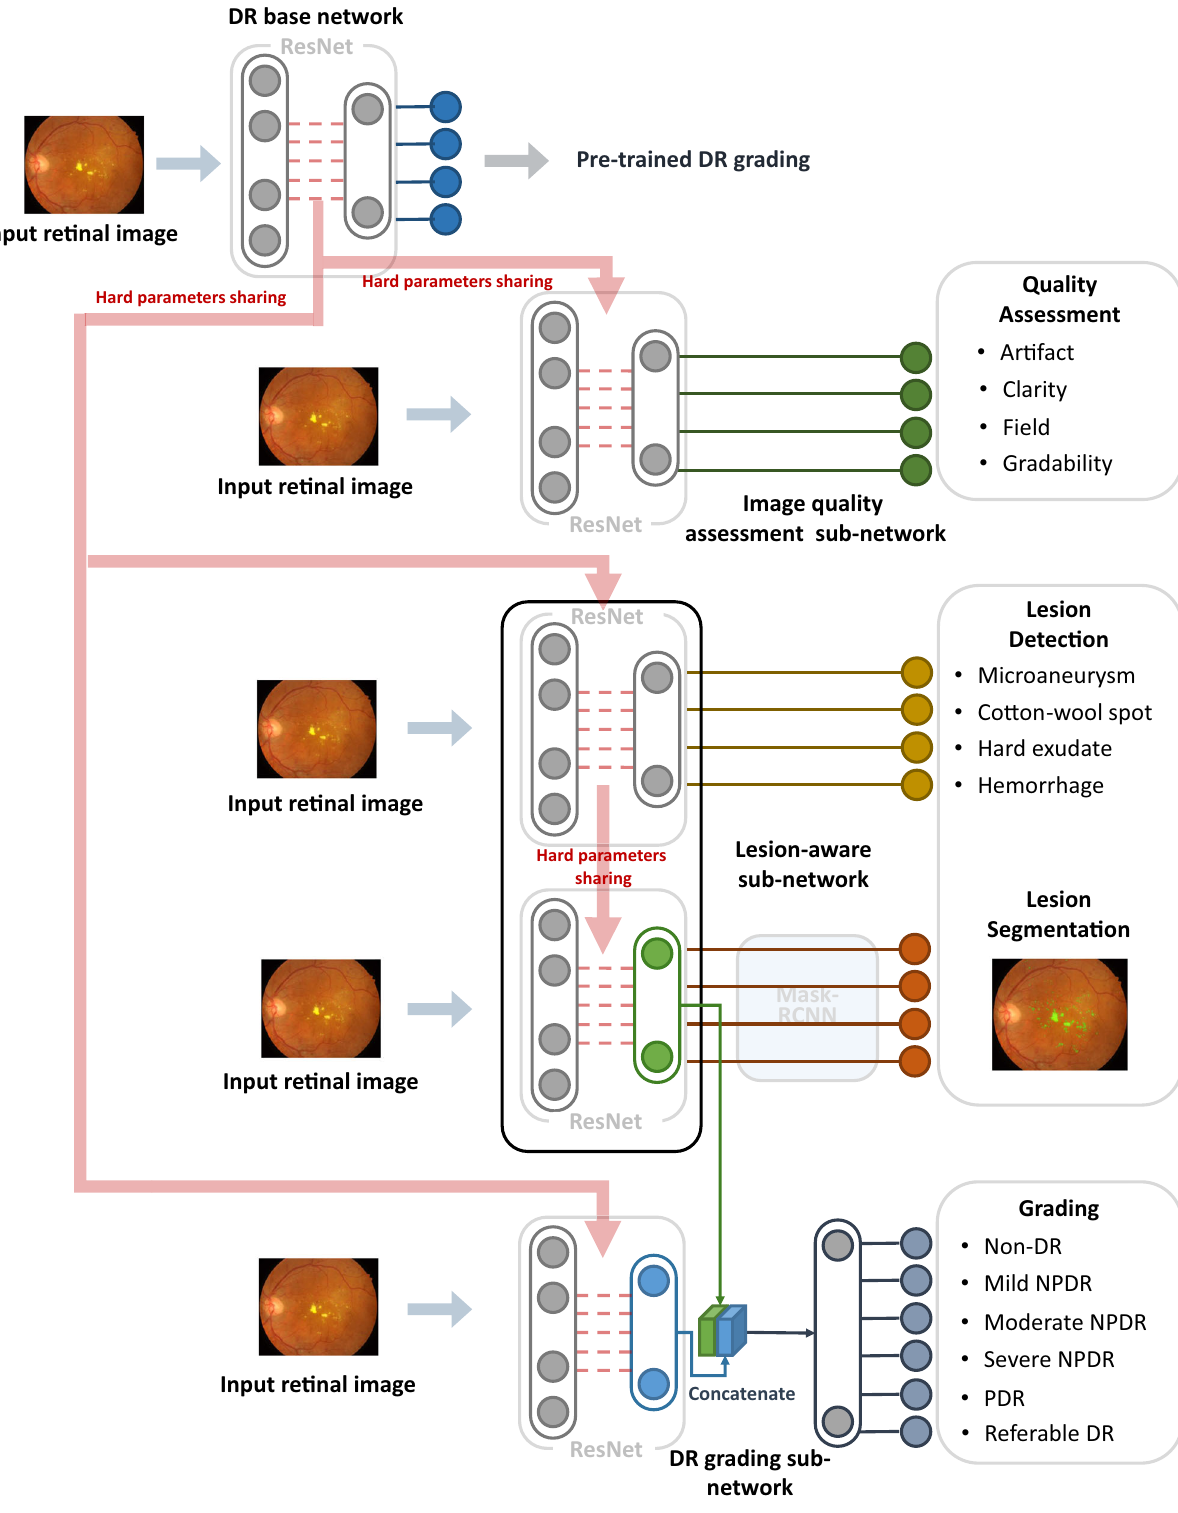
Fig. 2 Visual diagram of the DeepDR system. DeepDR system consisted of three sub-networks: image quality assessment sub-network, lesion-aware sub- network, and DR grading sub-network. We fi rst pre-trained the ResNet to form the DR base network (top row). The trained weights of the pre-trained DR base network were then shared in the three different sub-networks of the system, indicated by the red arrow. These three sub-networks took retinal images as input and performed different tasks one-by-one. Furthermore, the lesion features extracted by the segmentation module of the lesion-aware sub- network (indicated by the green arrow) were concatenated with the features extracted by the DR grading sub-network (indicated by the blue arrow). DR, diabetic retinopathy; NPDR, non-proliferative diabetic retinopathy; PDR, proliferative diabetic